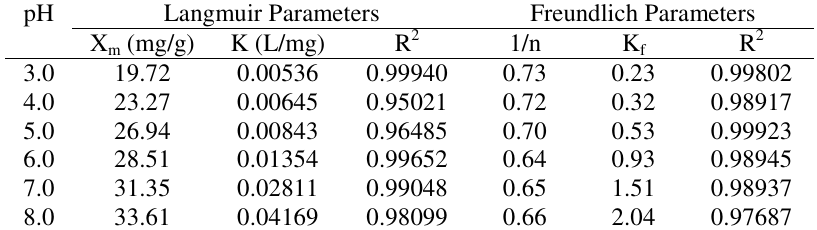
Table 2. Langmuir and Freundlich constants at different soprbate pH